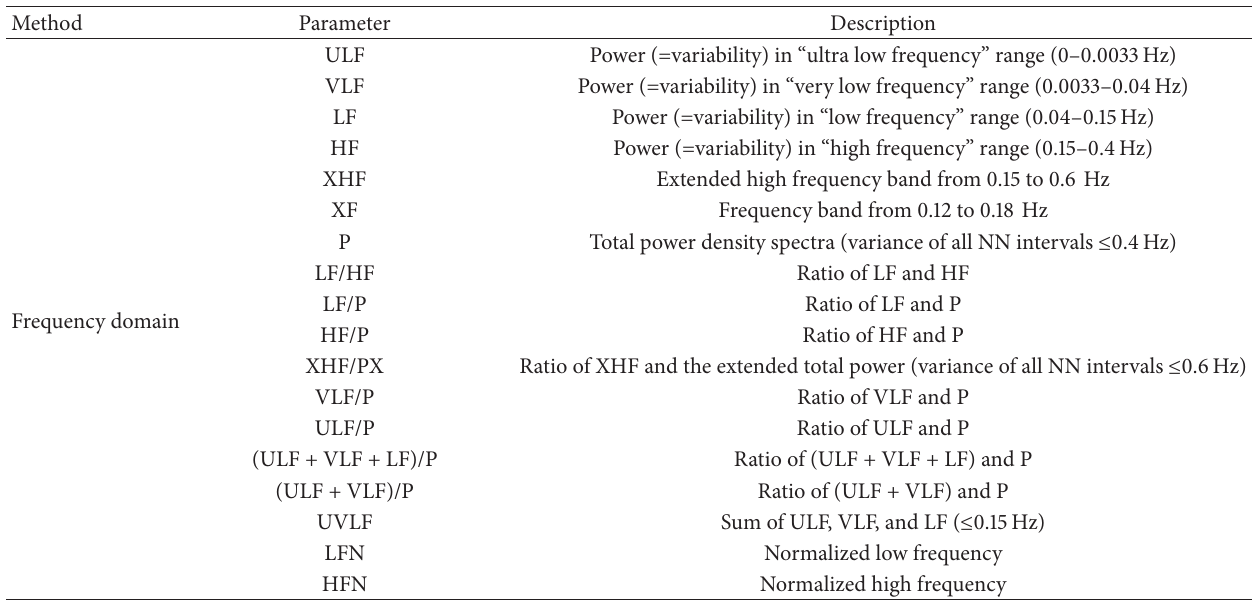
Table 2: Description of parameters calculated by frequency domain analysis. Parameters were calculated for heart rate and systolic and diastolic blood